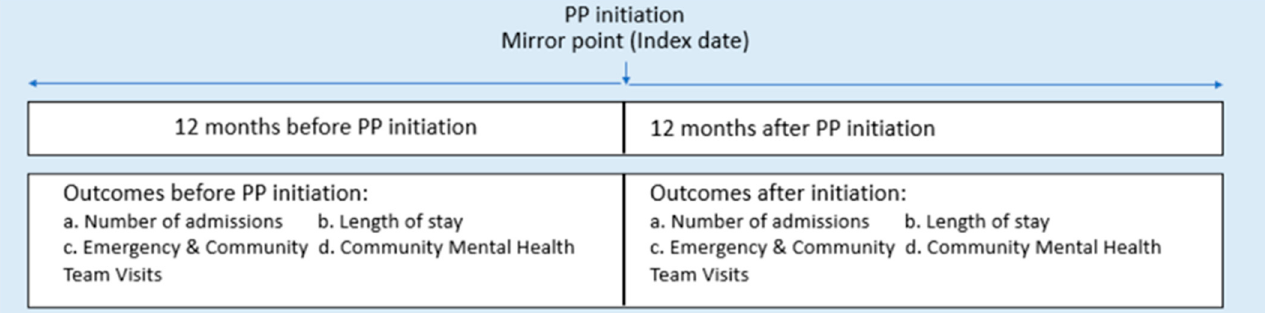
Figure 1. A mirror-image study design.